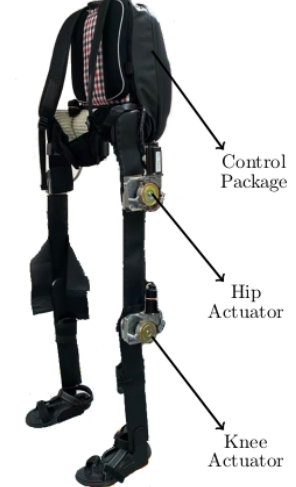
Figure 1. Structure of the wearable lower-limb exoskeleton.